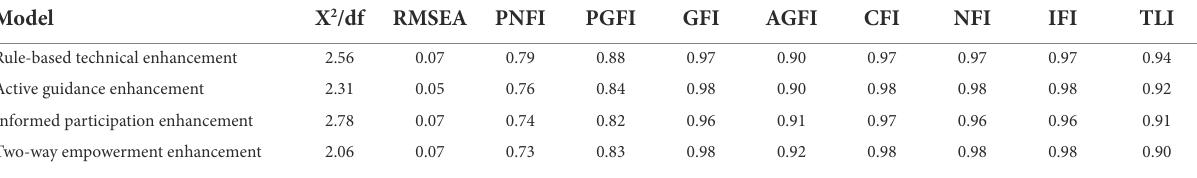
TABLE 1 Fitting results of the prediction model of parental-mediated intervention strategies.